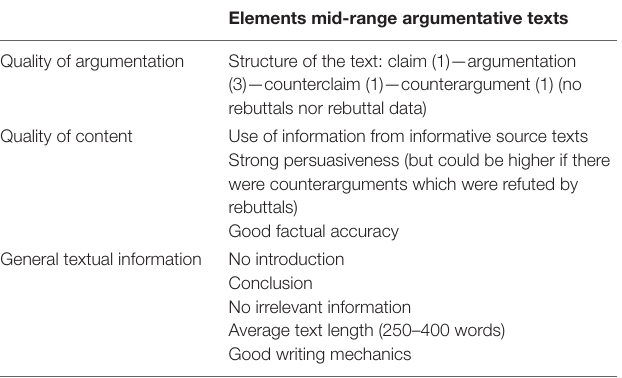
TABLE 10 | Elements of the mid-range argumentative text. Elements mid-range argumentative texts